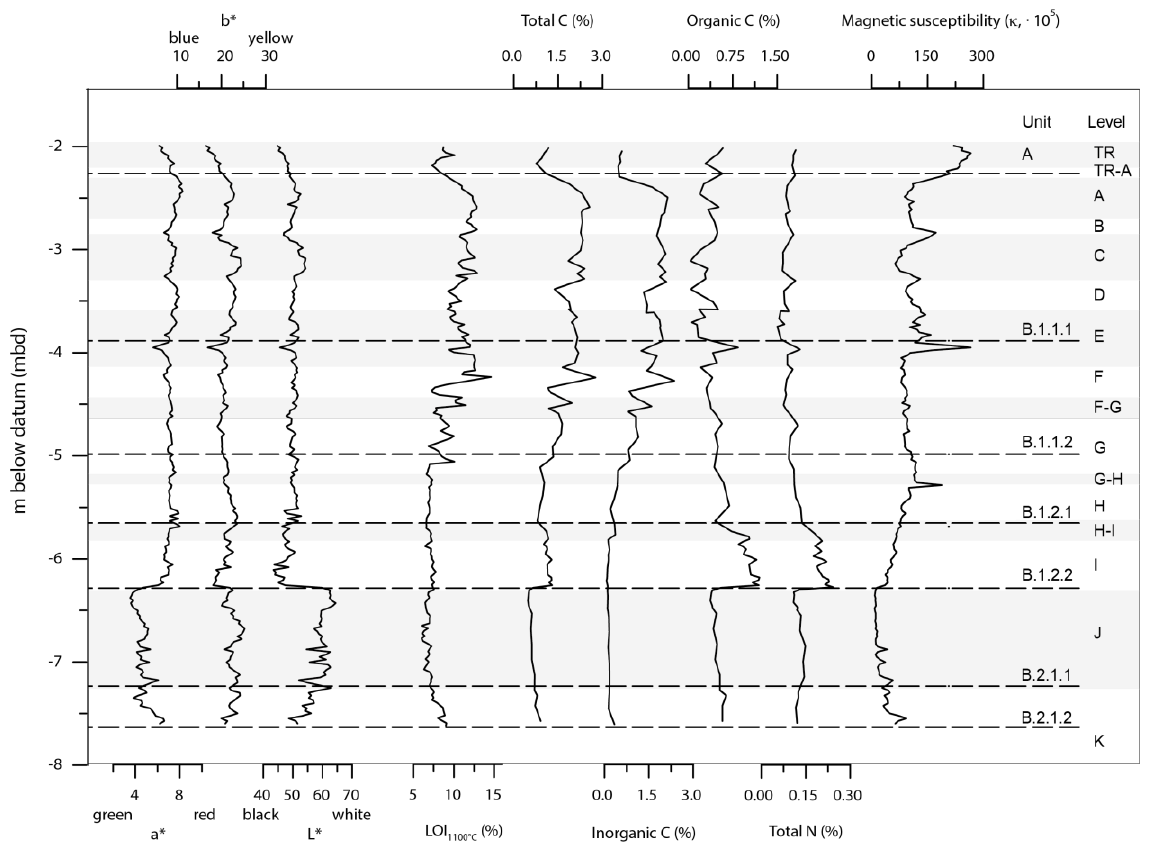
Figure 3. CIELab colour values, loss of ignition, total carbon and organic carbon, total N and magnetic susceptibility of the north profile at square E 0 at Arbreda.